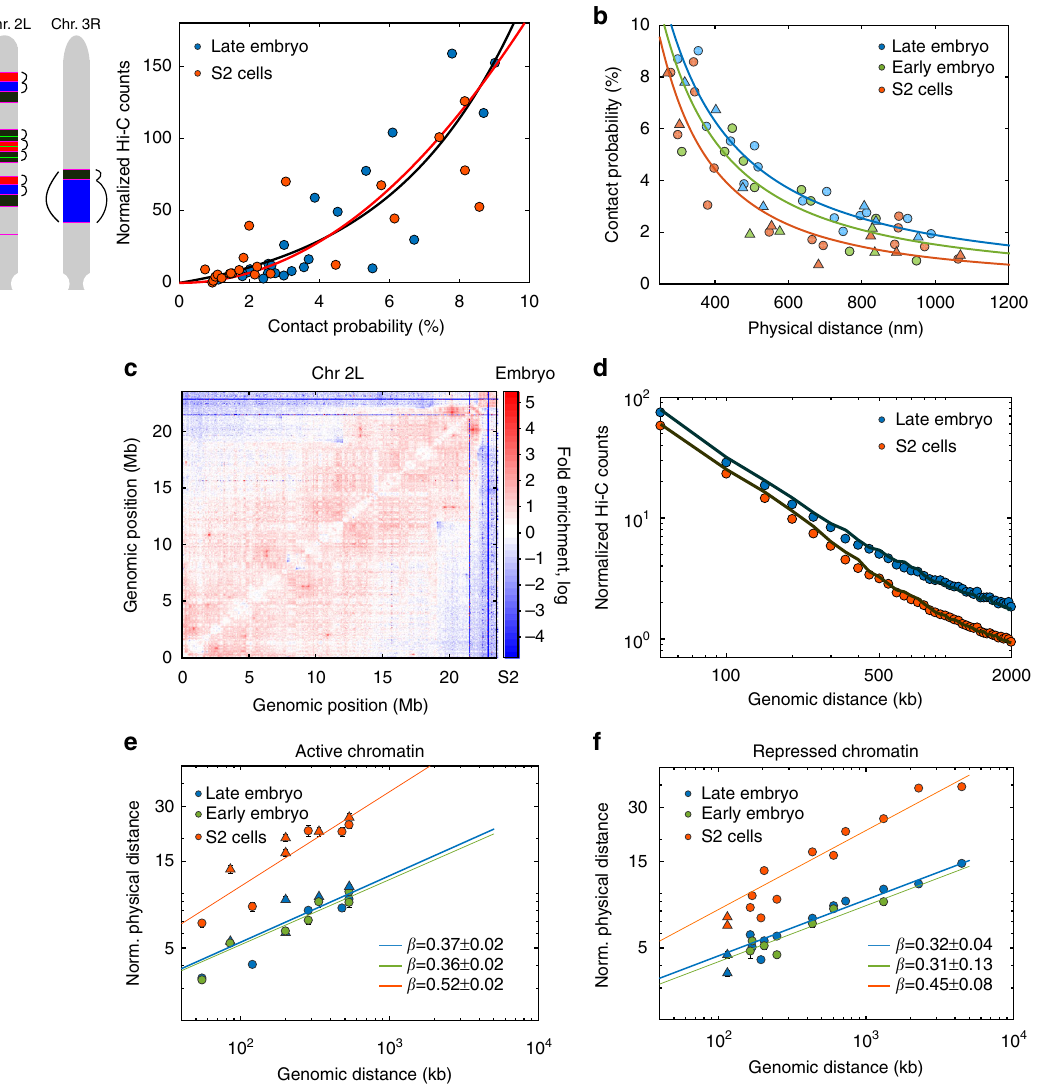
Fig. 2 Long-range absolute contact probability is speci fi cally modulated for each cell type. a Left, a schematic representation of pairwise distance measurements between consecutive and nonconsecutive borders, with color code and positions as in Fig. 1b. Right, normalized Hi-C counts vs. microscopy absolute contact probability for consecutive and nonconsecutive domain borders for embryo and S2 cells. Solid black and red lines represent exponential and power-law fi ts, respectively. Matrix resolution = 10 kb. N for microscopy pairwise measurements is provided in Supplementary Fig. 1f – h. N = 2 for Hi-C data, from at least three and two biological replicates, respectively. b Absolute contact probability vs. mean physical distance between probes for consecutive and nonconsecutive TAD borders ( fi lled circles). Solid lines represent power-law fi ttings with the scaling exponent described in Supplementary Fig. 2b. Triangles represent measurements within TADs. c Matrix of relative frequency of normalized Hi-C counts for late embryo vs. S2 cells for chromosome 2L. Contact frequency ratio is color coded according to scale bar. Matrix resolution = 50 kb. N = 4, biological replicates. d Log – log plot of normalized Hi-C counts between TAD borders vs. genomic distance for embryo and S2 cells. Solid lines represent the average contact frequency for randomly chosen positions in the genome. Matrix resolution = 10 kb. N = 2, biological replicates. e , f Log – log plot of the mean physical distance vs. genomic length for ( e ) active and ( f ) inactive/repressed chromatin domains for different cell types. Mean distance values were normalized by the pre-exponential factor from the power-law fi t of each data set (Supplementary Fig. 2d, e). Solid lines show the power-law fi ts, with the scaling exponent β shown in the panel. Circles and triangles are depicted as described in panel 2b. Error bars represent SEM. N > 140 for each data point, from more than three biological replicates (Supplementary Fig.